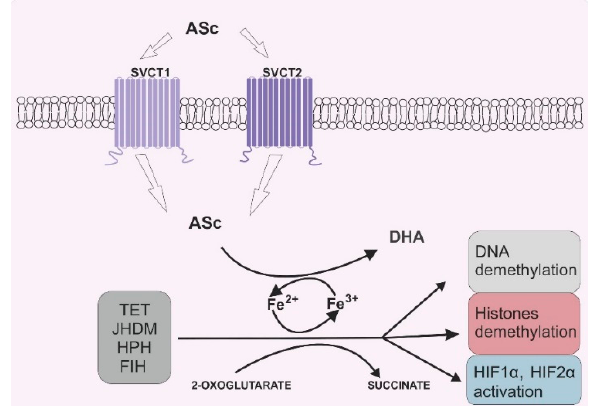
Figure 2. Vitamin C’s role in 2-oxoglutarate and Fe 2+ dependent dioxygenase (2-OGDD) activity. Figure2. VitaminC’srolein2-oxoglutarateandFe 2 + dependentdioxygenase(2-OGDD)activity.